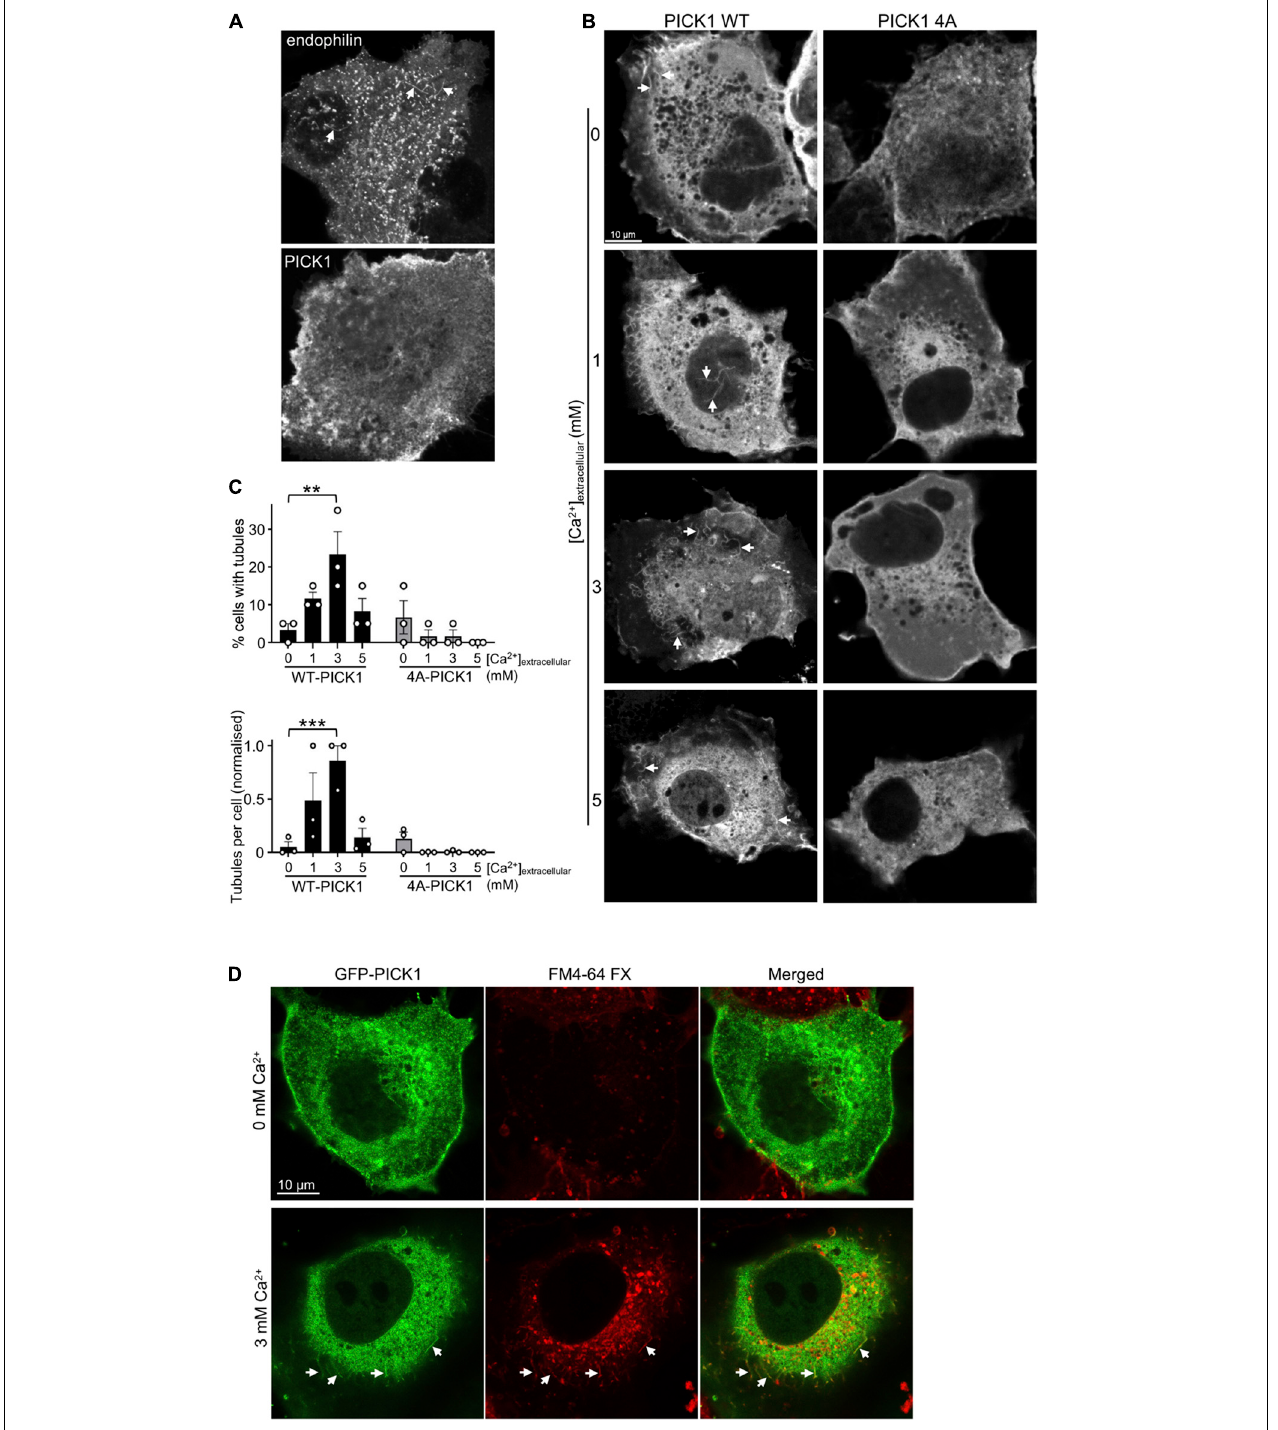
FIGURE 3 | Ca 2 + stimulates cellular membrane tubulation via PICK1 dimerization. (A) COS7 cells expressing GFP PICK1 or GFP endophilin were fixed and analyzed by confocal microscopy. GFP-positive tubular structures are detectable in cells expressing GFP-endophilin (arrowheads), but not in cells expressing GFP PICK1. (B) COS7 cells expressing GFP WT-PICK1 or GFP 4A-PICK1 were incubated in 0, 1, 3, or 5 mM extracellular Ca 2 + and 3 µ M ionomycin for 15 min prior to fixation and confocal microscopy. Arrows show tubular structures. (C) Quantification of the experiment is shown in B. Tubulation was analyzed as described in the “Materials and methods” section; 20 cells were analyzed per condition in each of three independent experiments. The top graph shows the percentage of cells with detectable tubules, and the bottom graph shows the mean number of tubules per cell. N = 3, ** p < 0.01, *** p < 0.001. (D) GFP PICK1 tubules originate from the plasma membrane. Cells were treated as in B, with the lipophilic dye FM4-64FX added at the same time as ionomycin. Confocal microscopy demonstrates the colocalization of GFP PICK1 with FM4-64FX. Arrows show tubular structures.